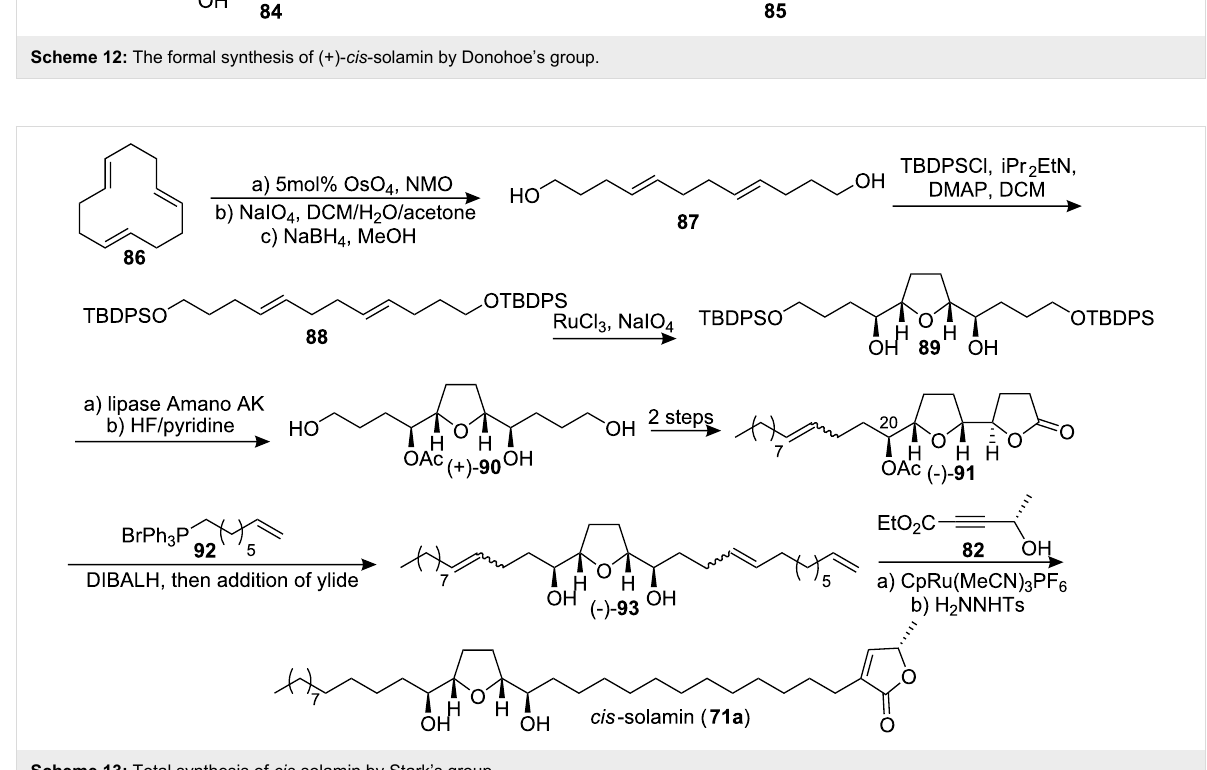
Scheme 13: Total synthesis of cis -solamin by Stark’s